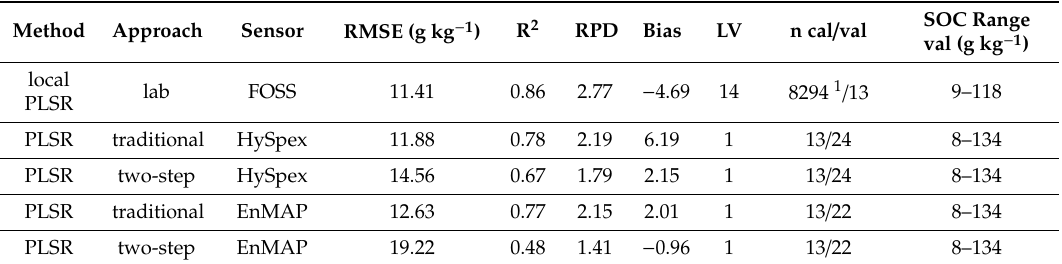
Table 2. Model results of the first step (laboratory, row 1), airborne HySpex (10 m bu ff er) with traditional and two-step approach (row 2–3) and simulated satellite EnMAP (30 m bu ff er) with traditional and two-step approach (row 4–5). RMSE: root mean squared error.